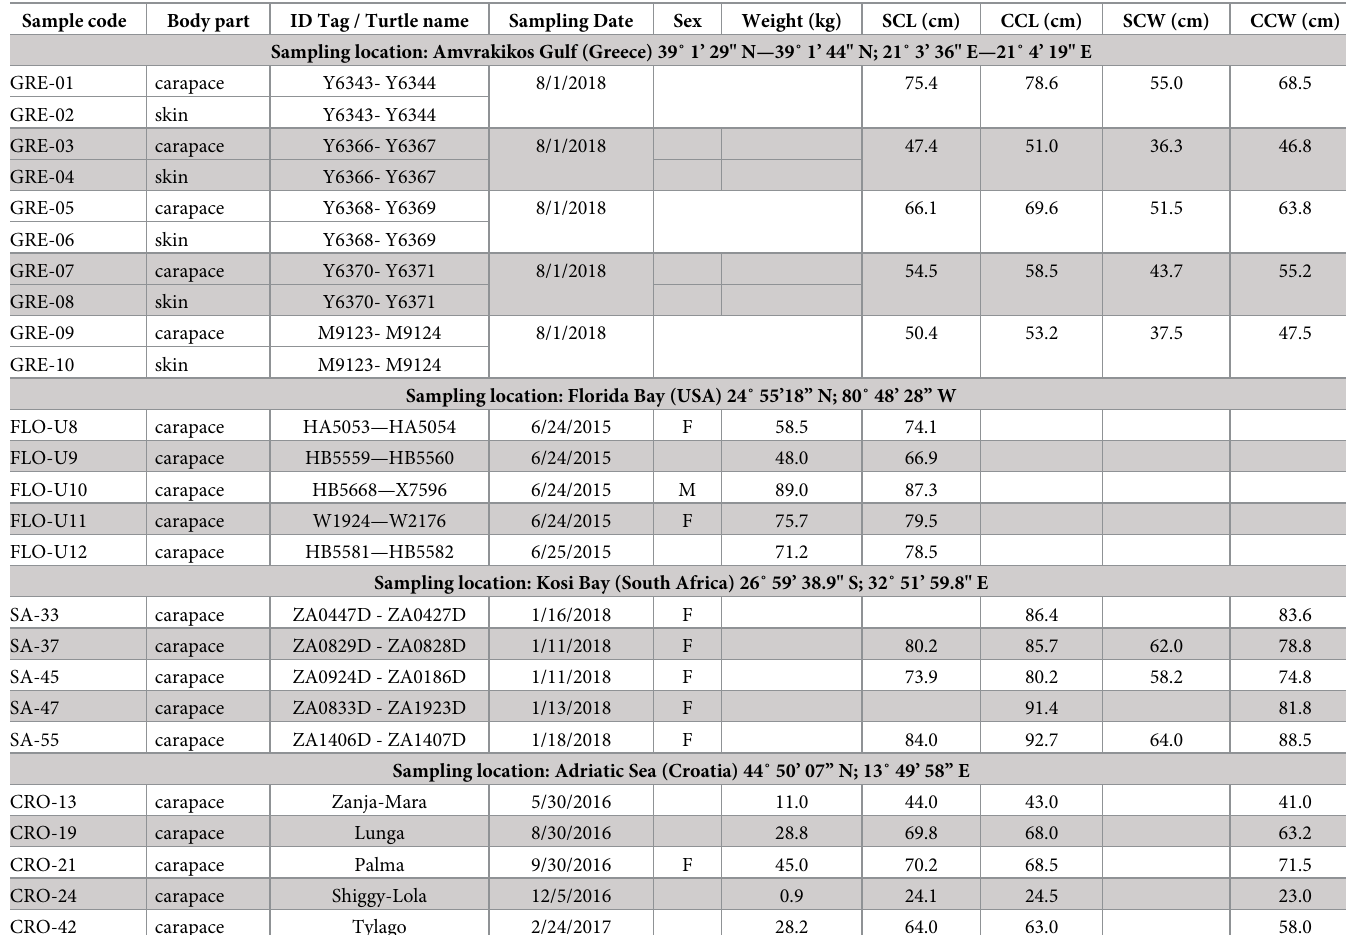
Table 1. List of samples and information on loggerhead sea turtles. Sample